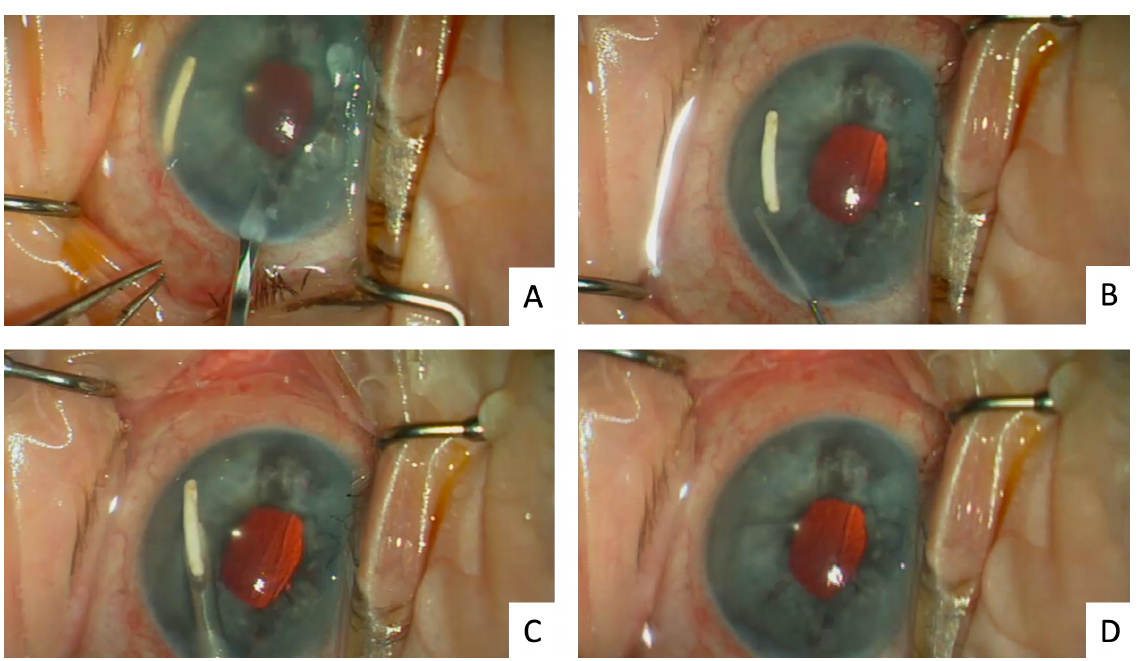
Figure 1: Surgical removal of the dexamethasone implant from the anterior chamber. A) Corneal incision. B) Positioning of the implant towards the incision using a cohesive OVD. C) Positioning of the 19-gauge needle around the implant. D) Final stage of the